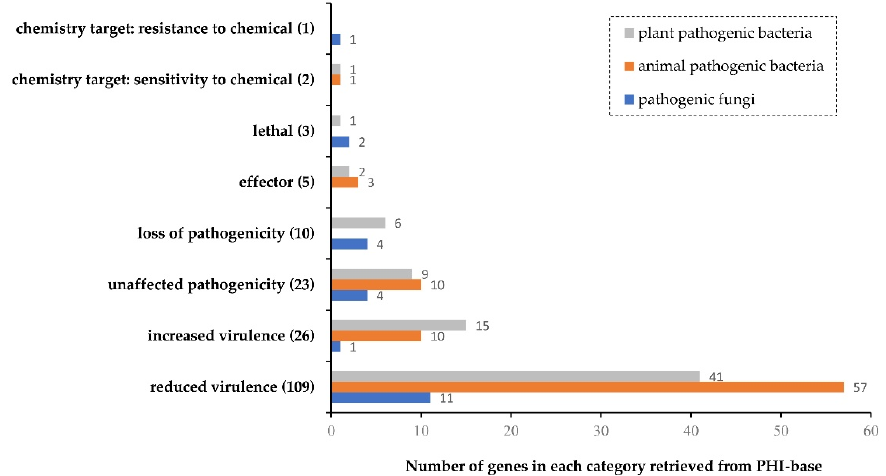
Figure 1. Phenotype classification of putative pathogenicity genes of X. albilineans retrieved from the pathogen–host interactions database (PHI-base).